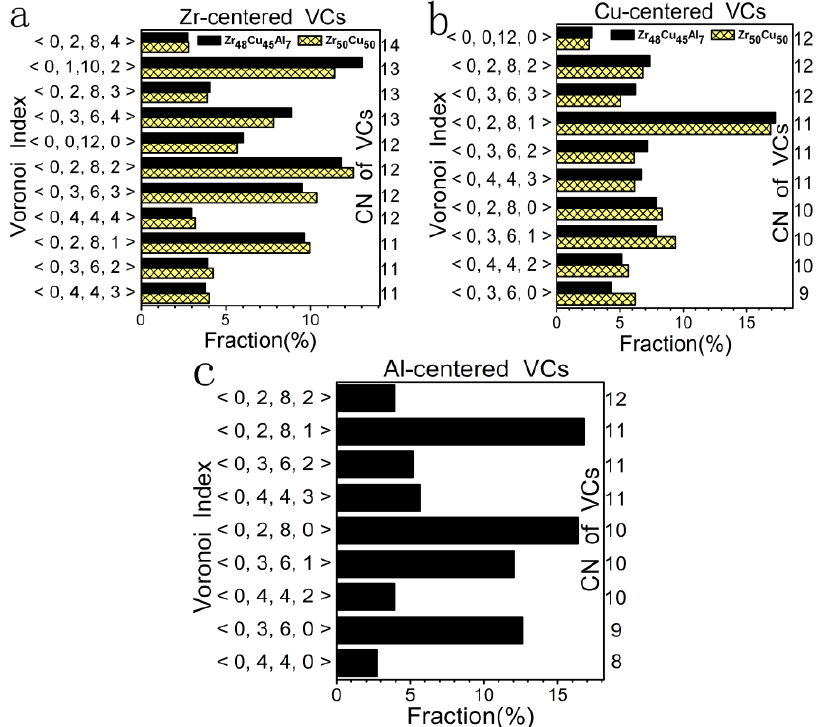
Figure A1. Distribution of major VCs, centered with ( a ) Zr; ( b ) Cu; and ( c ) Al atoms. Note only VCs possessing a weight over 2.5% are